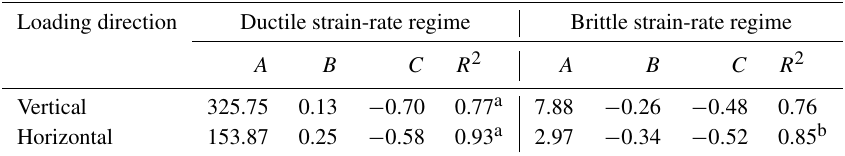
Table 3. The fitting coefficients of Eq. (6).